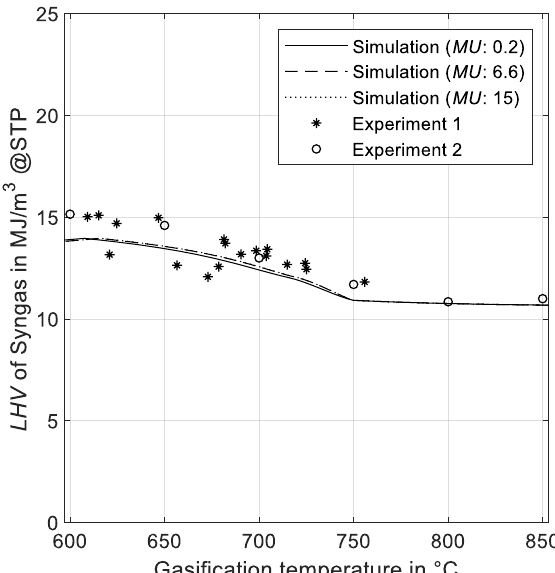
Figure 8. Simulated lower heating value ( LHV ) of syngas for gasification temperatures between 600 °C and 850 °C (lines for limestone make-up of 0.2, 6.6, and 15 kg/h); comparison with experimental results and 850 ◦ C (lines for limestone make-up of 0.2, 6.6, and 15 kg / h); comparison with experimental results from a 200 kW (Experiment 1) and 20 kW (Experiment 2) DFB system. from a 200 kW (Experiment 1) and 20 kW (Experiment 2) DFB